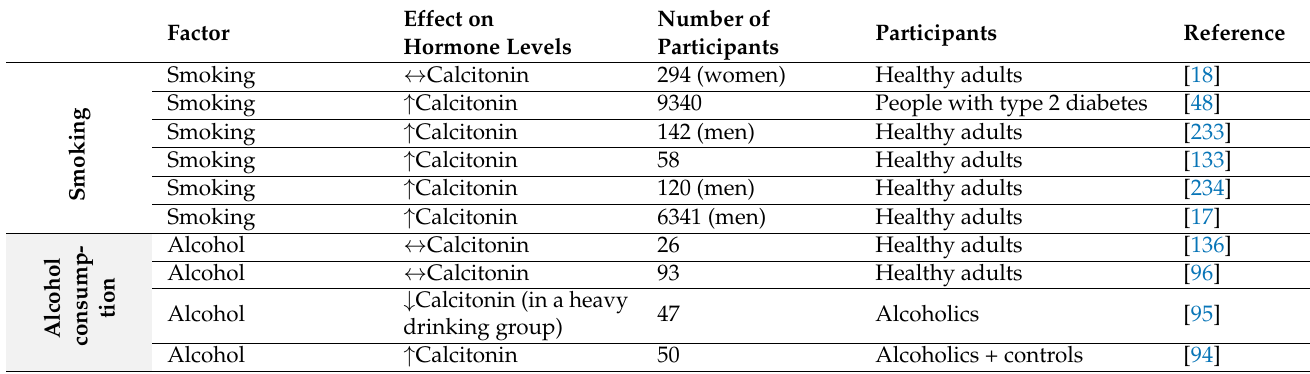
Table 2. Lifestyle factors that affect calcitonin levels in